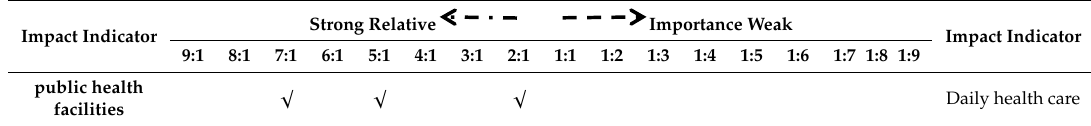
Table 2. Example of fuzzy level expert analysis expert questionnaire.